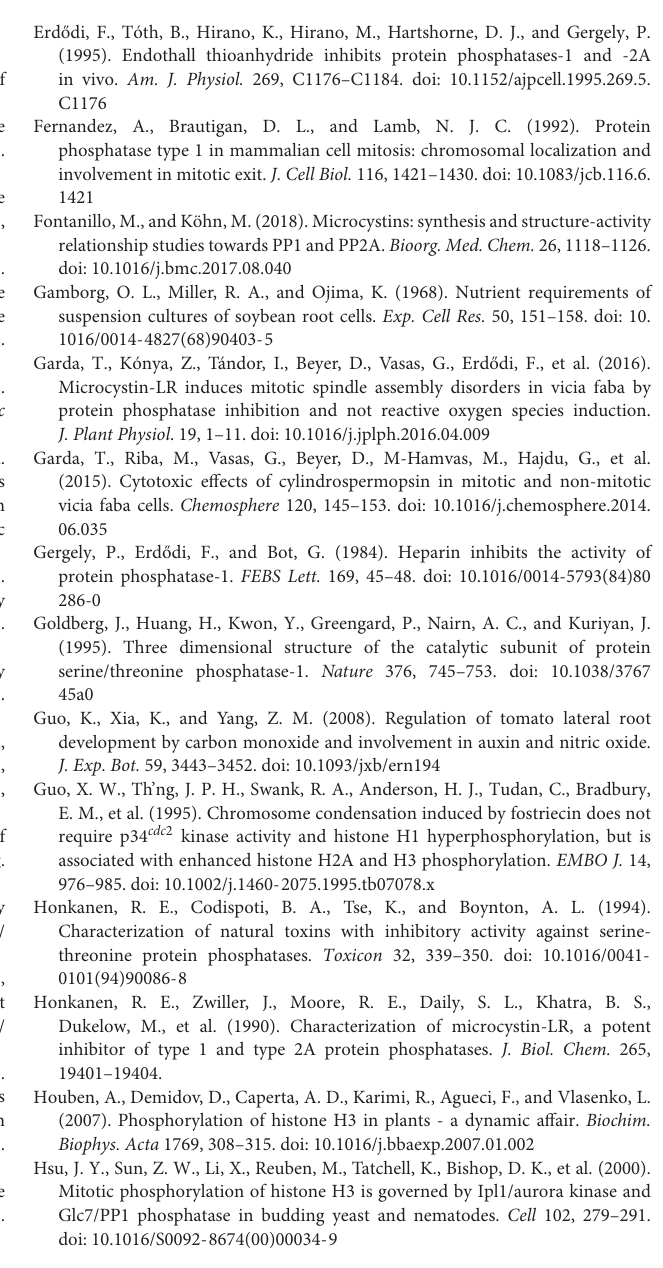
FIGURE S5 | Effects of okadaic acid (OA) and Tm on the protein phosphatase activities of lateral roots tips. (A) total PP1 + PP2A, (B) PP2A, (C) PP1. ∗ Significant differences of treatments to controls ( P < 0.05), n ≥ 6. FIGURE S6 | Conventional fluorescence microscopy images for phospho-histone H3 Ser10 (pH3 Ser10) labeling of metaphase (A–D) and anaphase (E–H) cells: (A,E) controls; treatments with: (B,F) 10 µ M AITC, (C,G) 10 µ M MCY-LR, (D,H) 10 µ M AITC + 10 µ M MCY-LR. Scalebars: 10 µ m. FIGURE S7 | Effects of low AITC and MCY-LR concentrations on histone H3 Ser10 phosphorylation in metaphase (A) and anaphase (B) cells. Effects of 0.2 µ M OA and 0.2 µ M Tm on histone H3 Ser10 phosphorylation in metaphase (C) and anaphase (D) cells. ∗ Significant differences of treatments to controls ( P < 0.05), n ≥